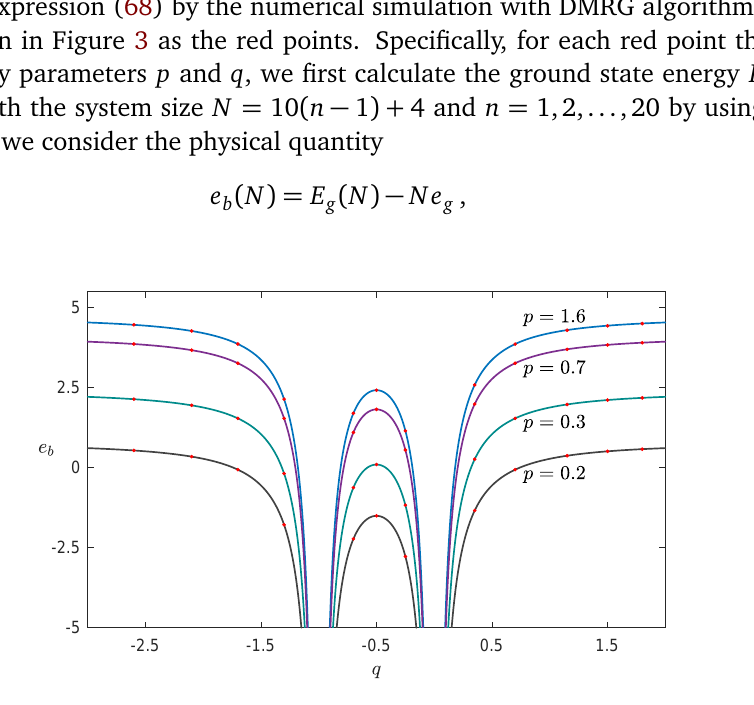
Figure 3: Boundary energies versus the boundary parameters p and q . The coloured curves are those calculated from the analytical expression (68) and the red points are those obtained from the DMRG. The values of q at the red points are q = − 2.6, − 2.1, − 1.7, − 1.3, − 0.7, − 0.5, − 0.25,0.35,0.7,1.15,1.5 and